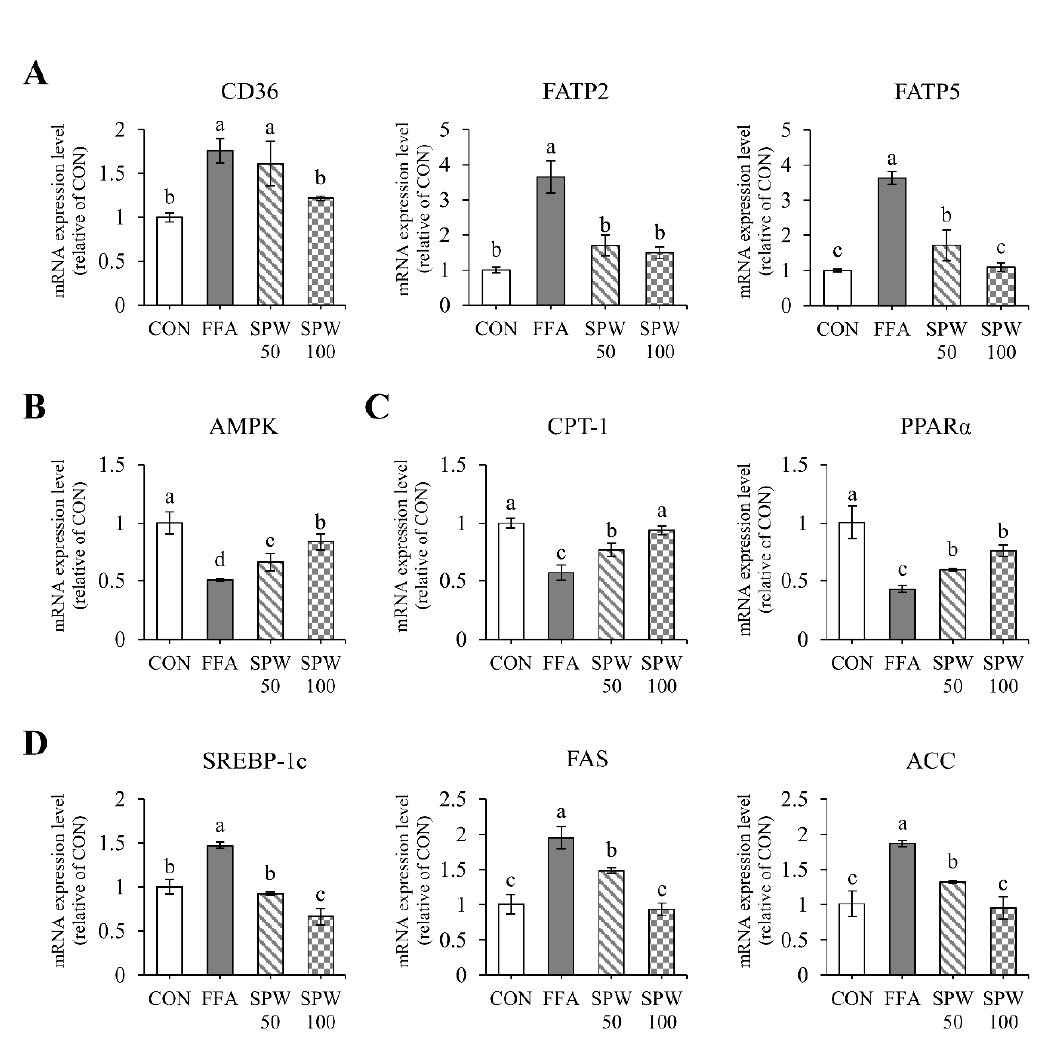
Figure 2. Salvia plebeia R. Br. water extract (SPW) treatment regulated the expression of genes related to lipid metabolism in FFA-induced HepG2 cells. The mRNA expression level of ( A ) lipid uptake markers, CD36, FATP2, and FATP5; ( B ) lipid metabolism markers, AMPK, LXR α , and LXR β ; ( C ) β -oxidation markers, CPT-1 and PPAR α ; and ( D ) lipid synthesis markers, SREBP-1c, FAS, and ACC. Data are expressed as mean ± SD ( n = 4 for each group). CON, control; FFA, free fatty acid; SPW 50, FFA + SPW 50 µg/mL; SPW 100, FFA + SPW 100 µg/mL; CD36, cluster of differentiation 36; FATP2, fatty acid transport protein 2; FATP5, fatty acid transport protein 5; AMPK, AMP-activated protein kinase; LXR α , liver X receptor α ; LXR β , liver X receptor β ; CPT-1, carnitine palmitoyl transferase-1 α ; PPAR α , peroxisome proliferator-activated receptors α ; SREBP-1c, sterol regulatory element binding protein-1c; FAS, fatty acid synthase; ACC, acetyl-CoA carboxylase. Different letters above the bar indicate statistical difference based on the Duncan’s multiple range test ( p < 0.05, a > b > c > d).